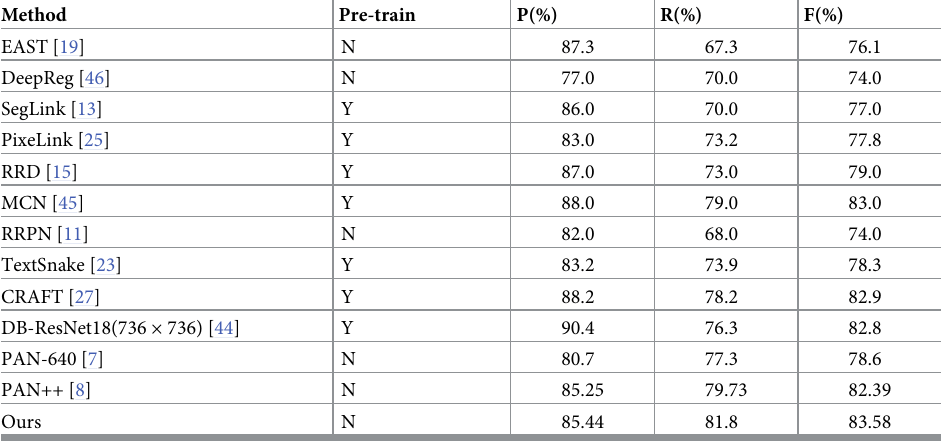
Table 6. Experimental results at MSRA-TD500 with a scale of 736 × 736, pre-train represents whether to use the pre-training dataset for fine-tuning. “Y” means using pre-training, “N” means not using pre-training. “P”, “R” and “F” stand for “precision”, “recall” and “F-measure” respectively. PAN++ [8] is the detection